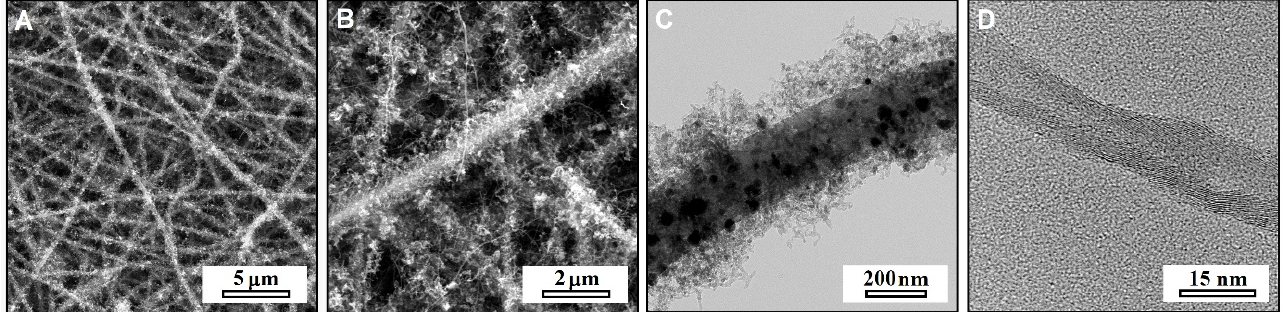
Figure 1. SEM ( A , B ) and BFTEM ( C ) images of hierarchical nanofibers—eCNF/CNT/NiCo. ( D ) HRTEM close-up of MWCNT.